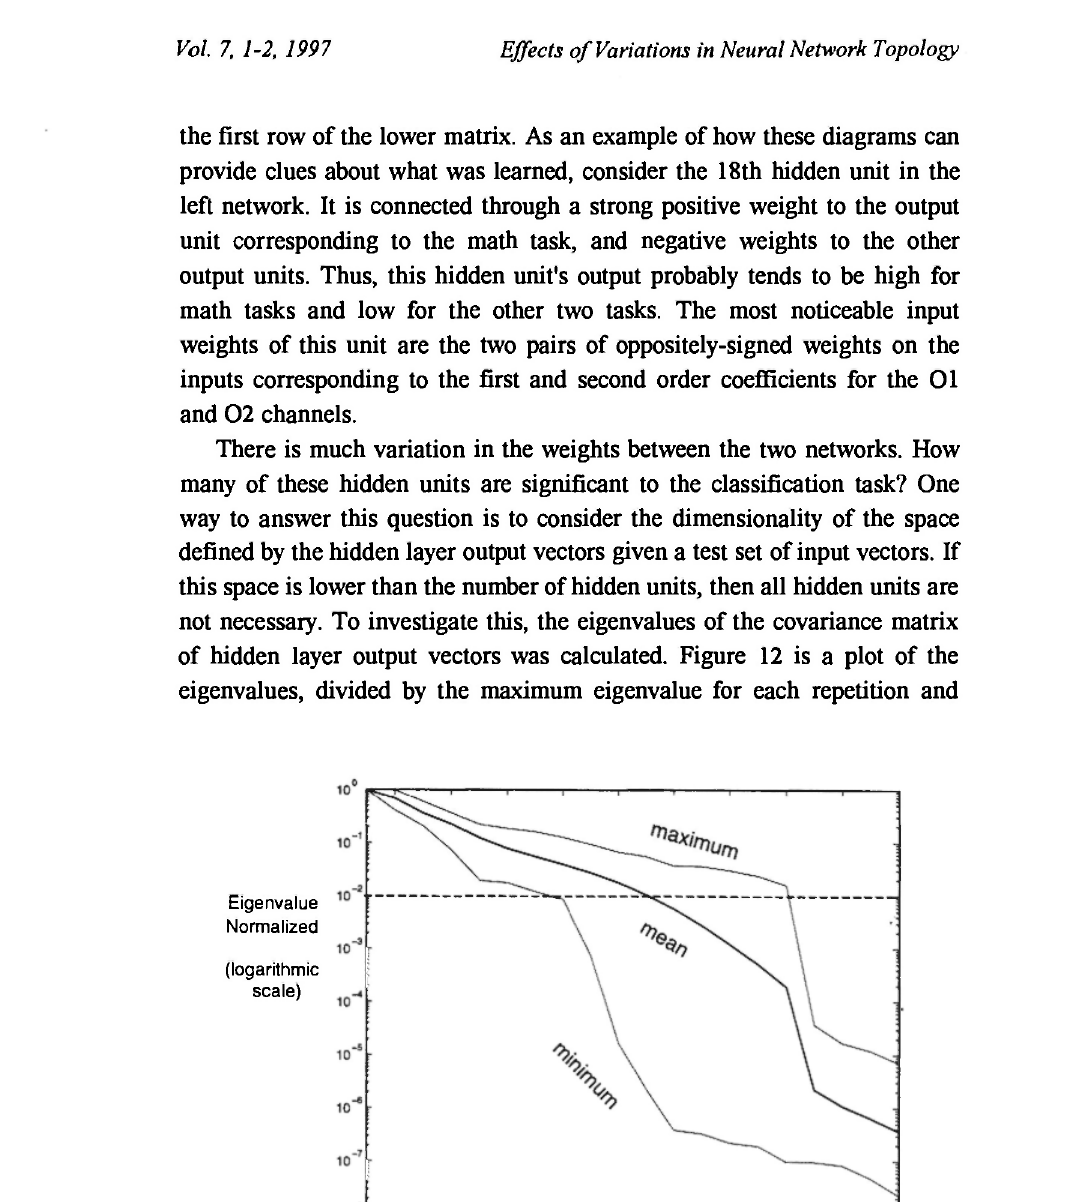
Fig. 12: Range of normalized eigenvalues of covariance matrix of hidden layer outputs for test set over 90 repetitions. Values are normalized by dividing by the maximum eigenvalue for each repetition. The horizontal line is at a value of 0.01, below which eigenvalues are considered to be